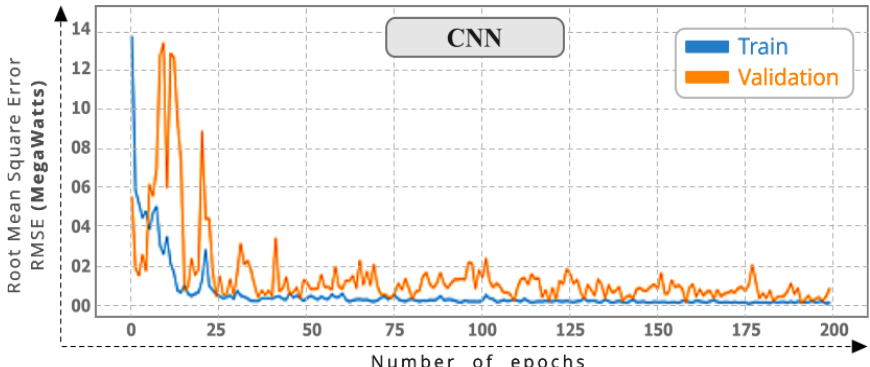
Figure 6. CNN loss function behavior according to the number of epochs.